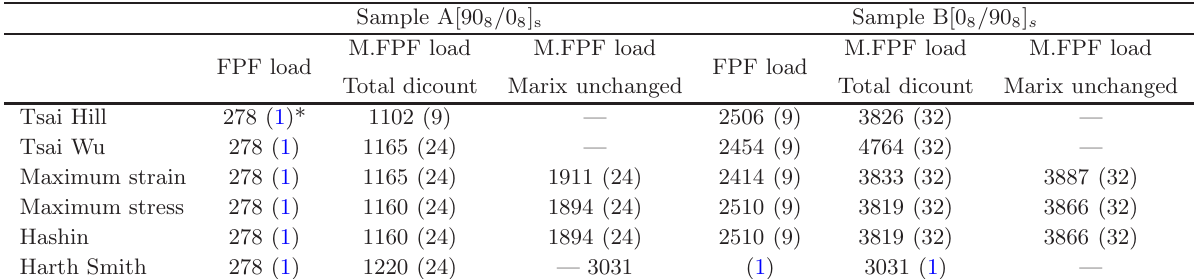
Table 5. Failure loads for samples A and B.